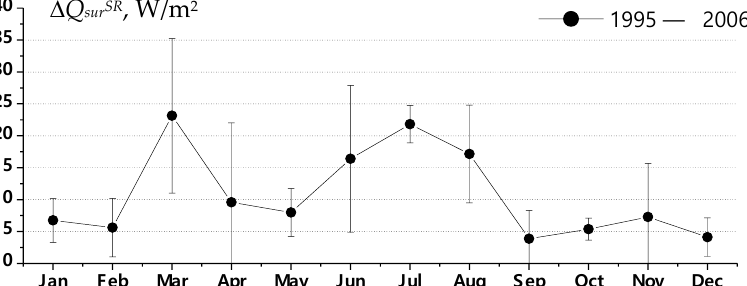
Figure 2. Dynamics of the difference between the fluxes of absorbed shortwave radiation in the urban and rural areas Δ Q surSR .